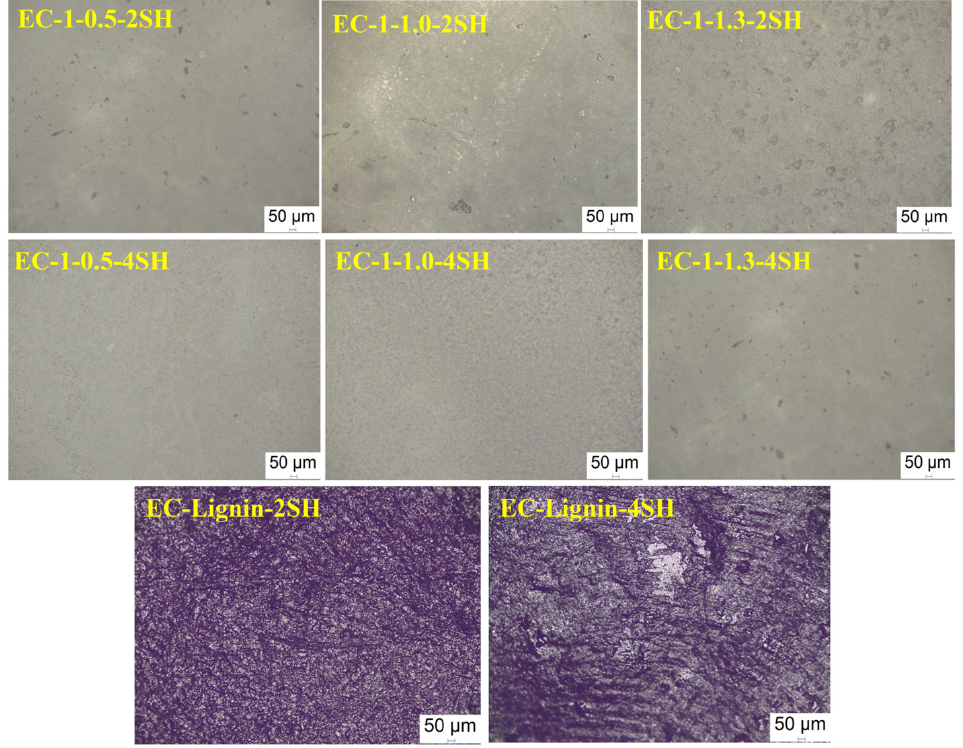
Figure 17. Microstructure of the cross − linked polymers.